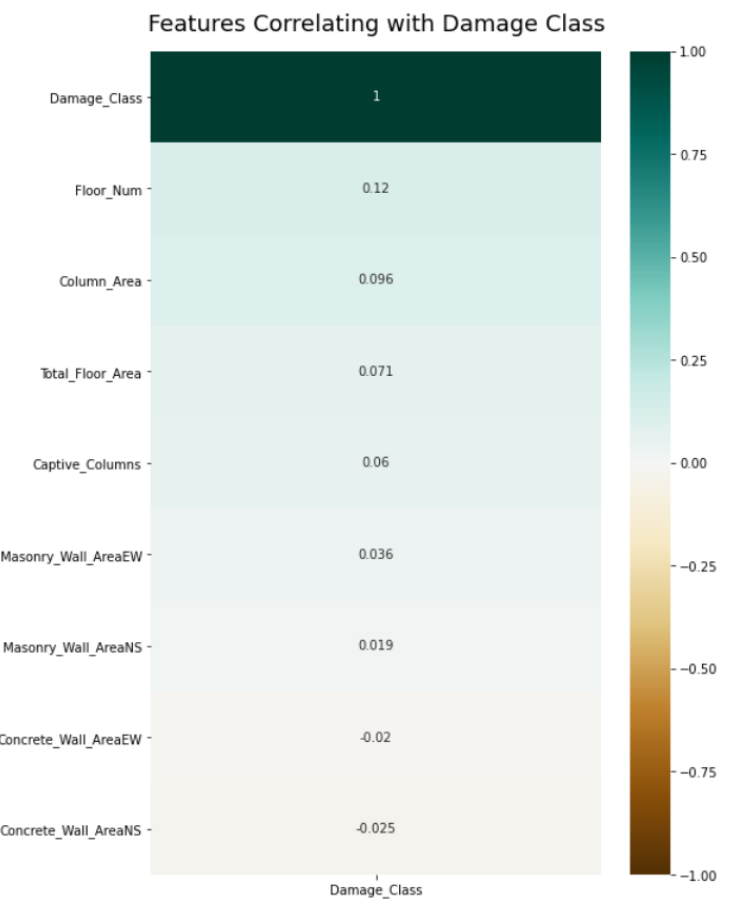
Figure 9. Heatmap illustrating correlation coefficient between independent and dependent